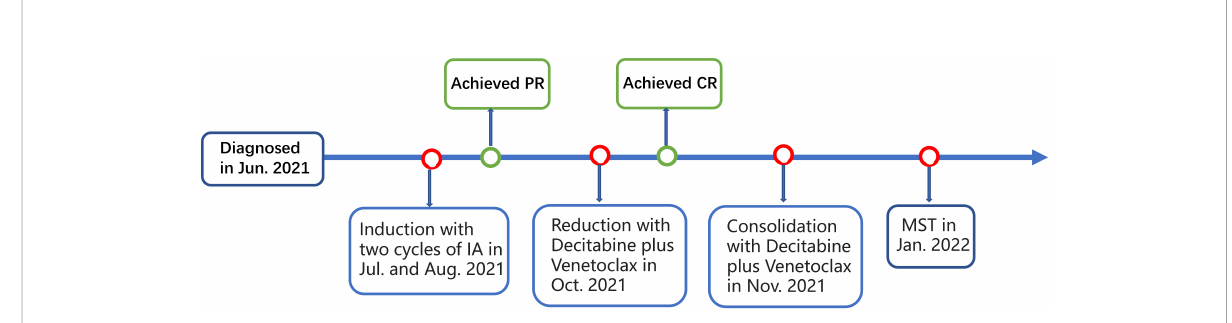
FIGURE 1 Schematic representation of the patient ’ s treatment history. IA, idarubicin and cytarabine; PR, partial remission; CR, complete remission; MST,